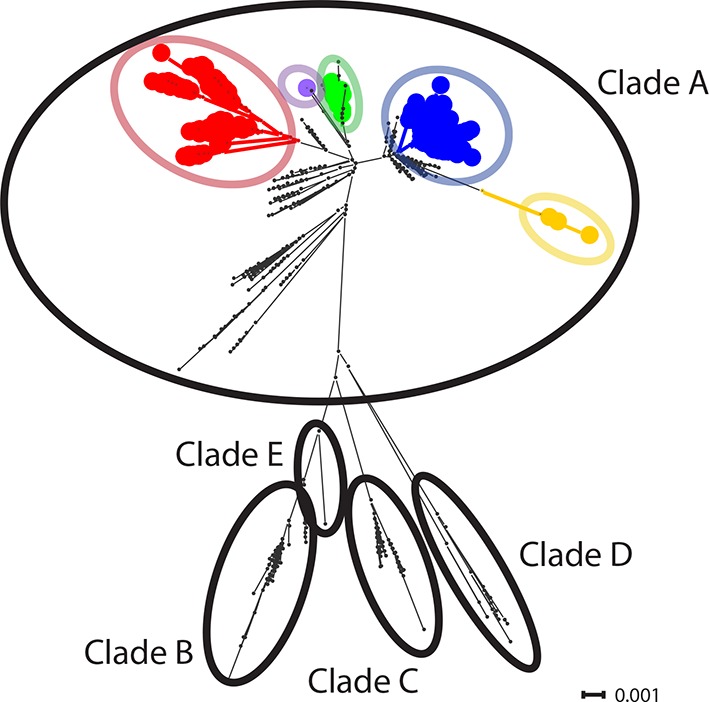
CTVT mtDNA clades 1 to 5 all arose from dog mtDNA clade A.Maximum likelihood phylogenetic tree constructed with complete mtDNA sequences from 449 CTVT tumours and 590 dogs. Coloured and black dots represent CTVT and dog mtDNA respectively (CTVT mtDNA clade colours are represented as in Figure 1A). Dog mtDNA clades A to E are labelled (Savolainen et al., 2002; Vila et al., 1997). Scale bar indicates base substitutions per site.